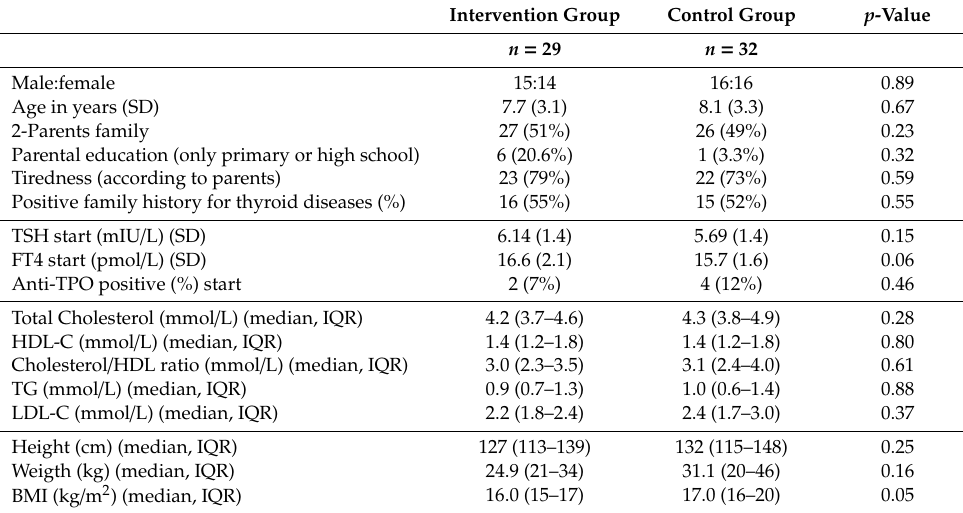
Table 1. Patient characteristics (chi square tests; sex, two-parent family, parental education, tiredness, family history, presence anti-TPO. Independent t -test; age. Mann–Whitney test; Total Cholesterol (TC), high-density lipoprotein (HDL), cholesterol / HDL ratio, triglycerides (TG), low-density lipoprotein (LDL), height, weight and BMI).